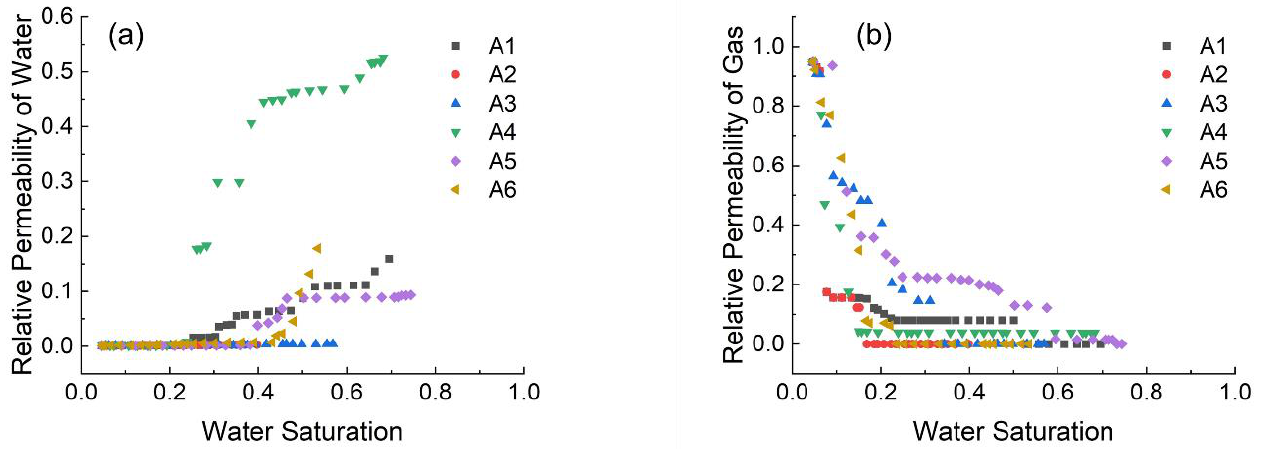
Figure 12. Specific surface area of flooded channels for twelve cases.